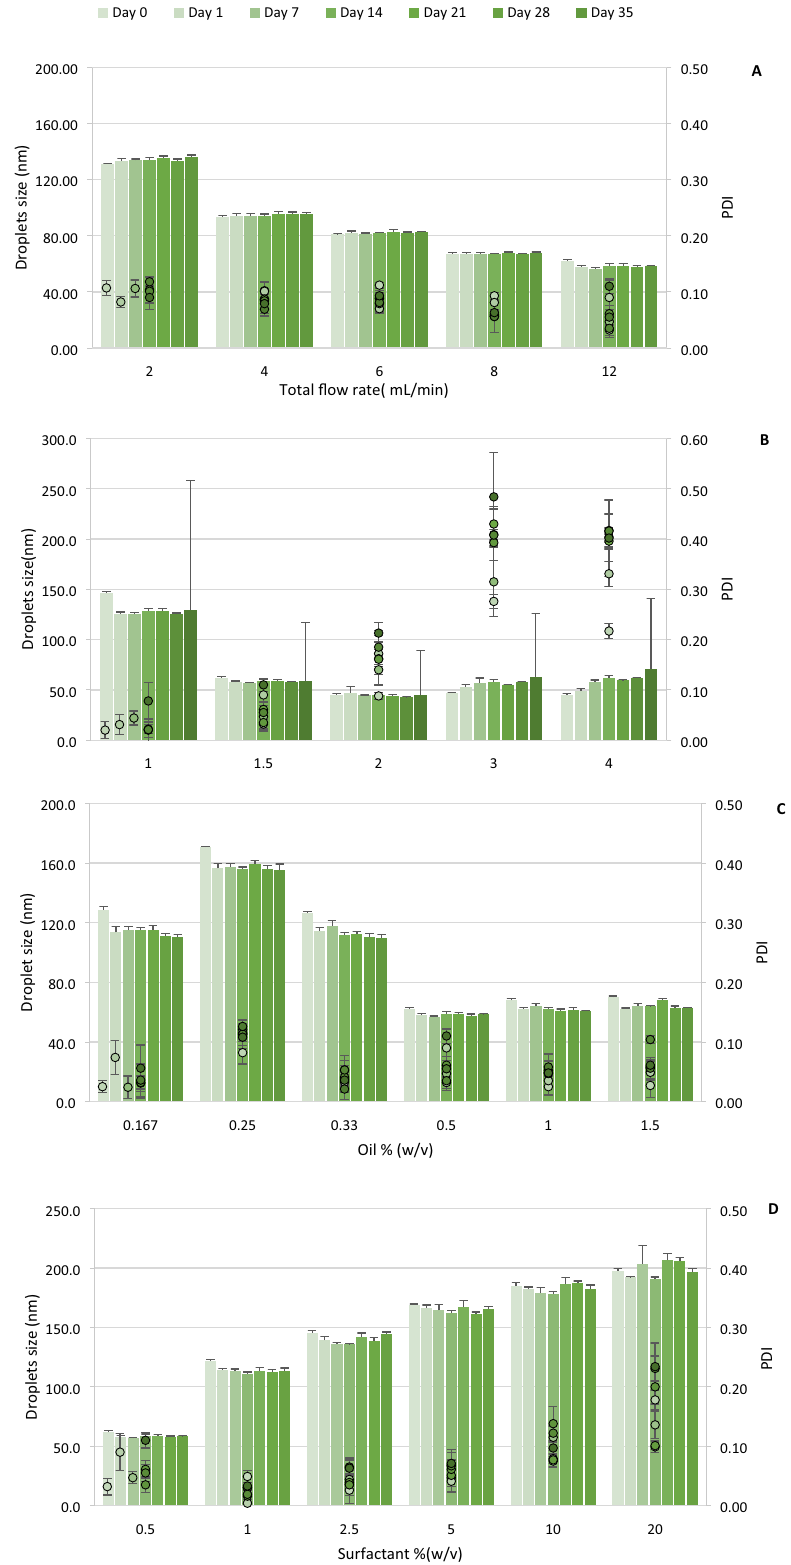
Figure 5. Effect of formulation parameters on mean droplet size (bars) and PDI (points) of HSO nanoemulsion prepared by microfluidic mixing upon 35 days of storage at different: ( A ) Total flow rate (TFR); ( B ) Flow rate ratio (FRR); ( C ) Oil concentration; ( D ) Surfactant concentration. Each point represents the mean value ± SD ( n =